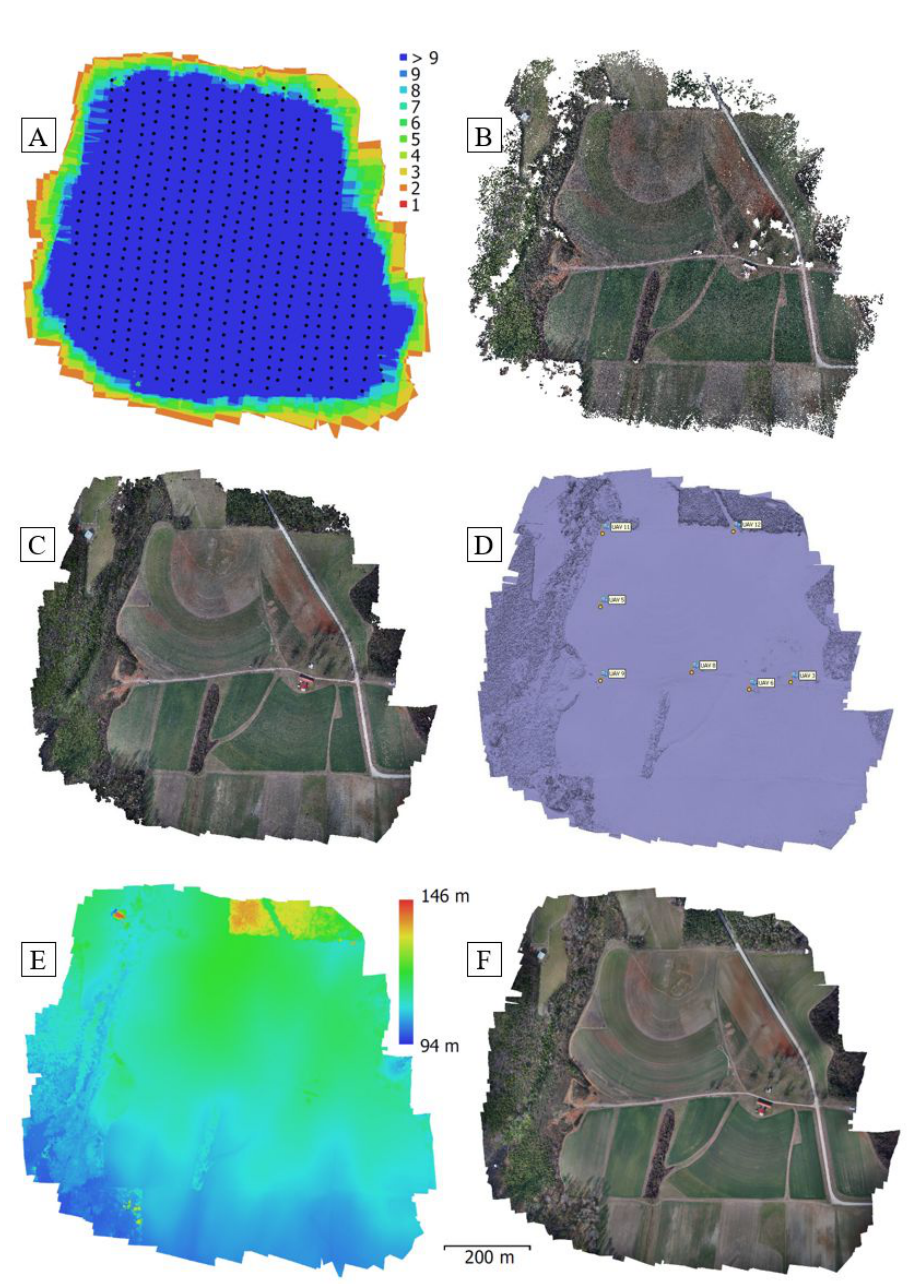
Figure 15. An example UAS image processing workflow. ( A ) photo capturing positions and image overlap; ( B ) sparse point cloud; ( C ) dense point cloud; ( D ) mesh with indicated positions of Ground Control Points; ( E ) Digital Surface Model; ( F )